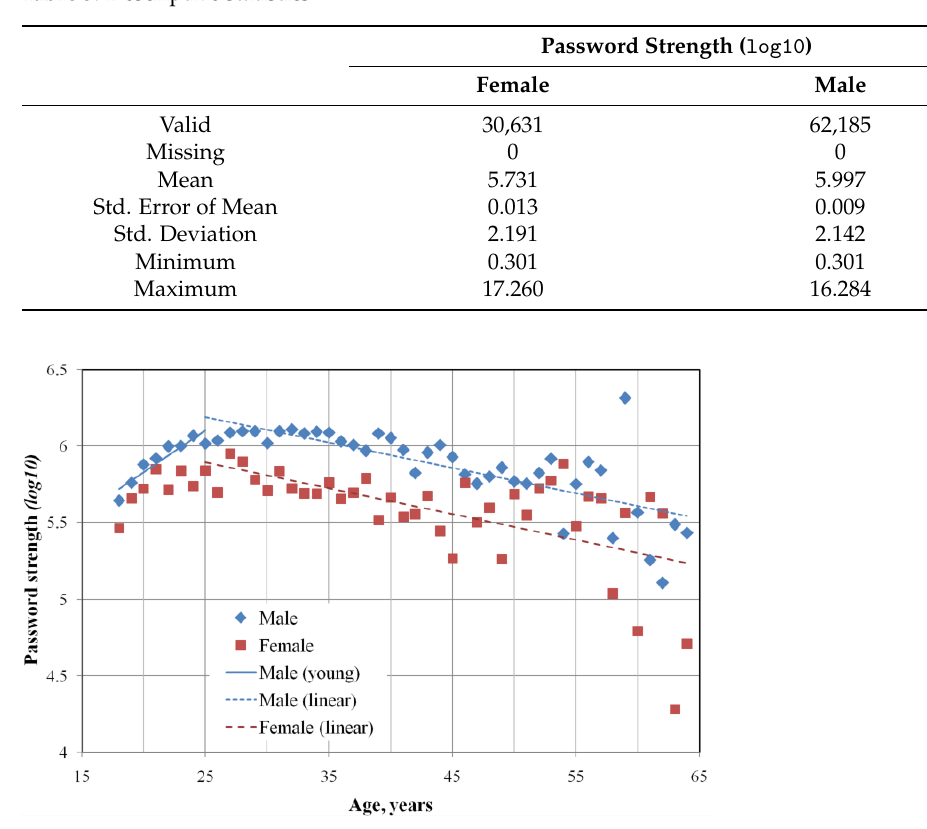
Figure 3. Histogram of password strengths. Table 5. Descriptive statistics.